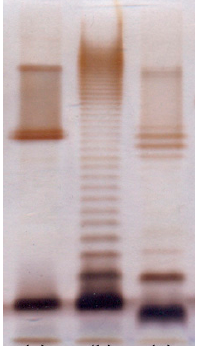
Figure 6. LPS profiles of ( a ) A. hydrophila AH-1; ( b ) A. piscicola AH-3; and ( c ) A. bivalvium 868E T by SDS-PAGE.